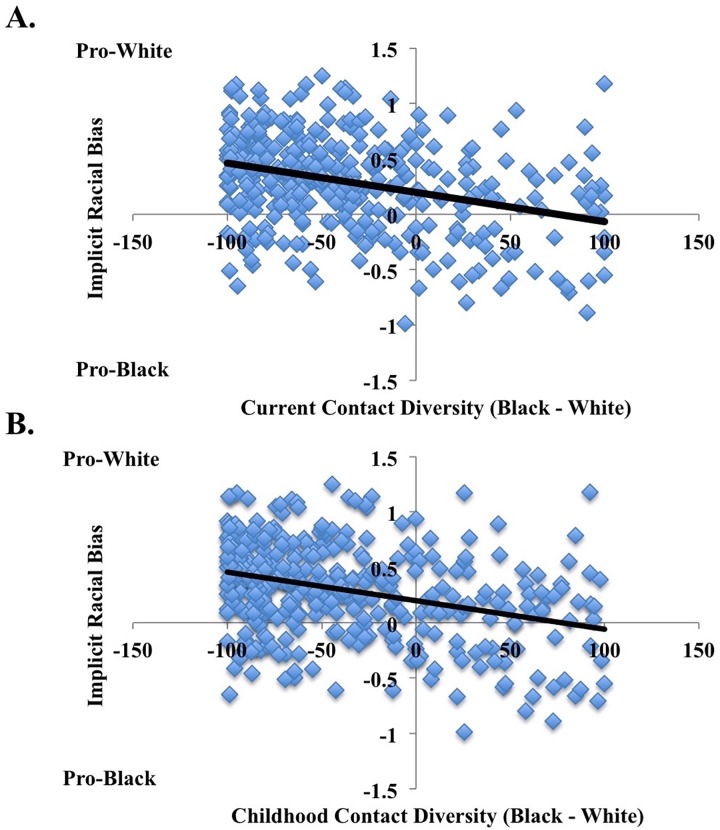
Relationship between current (Panel A) and childhood contact (Panel B) and implicit racial bias in Study 2 for all participants. Higher values on implicit racial bias refer to more pro-White associations and lower numbers refer to more pro-Black associations. Overall, greater diversity in contact (Black contact–White contact) related to lower implicit racial bias (IAT D-scores).